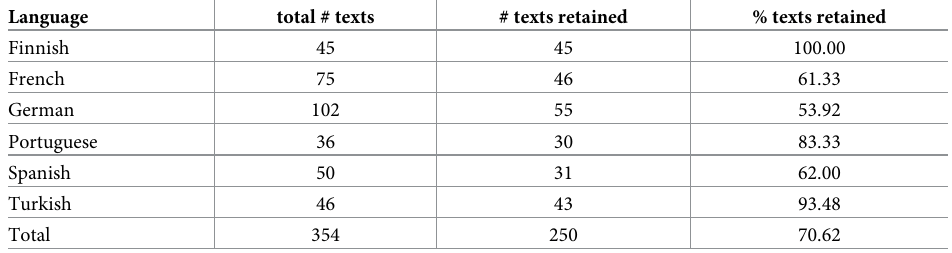
Table 1. The total number of texts obtained per language and the number and percentage of texts retained in the